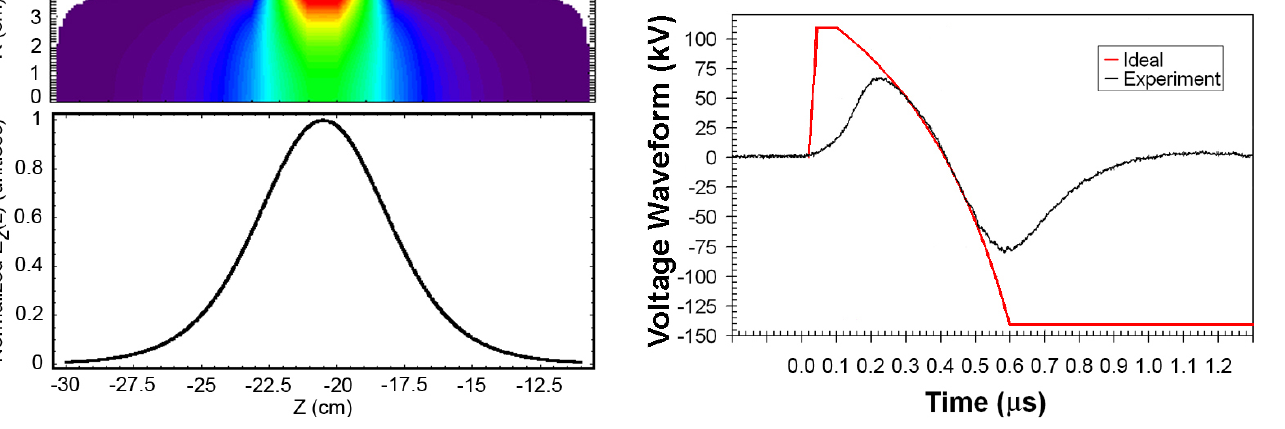
FIG. 2. (Color) In models describing NDCX, the axial coordi- nate is measured in the laboratory frame from Z (cid:8) (cid:1) 30 cm to Z (cid:8) (cid:2) 120 cm . Top: Snapshot (in time) of the E tilt acceleration gap, calculated from the geometry of the currently existing induction module on NDCX. Bottom: Slice of E tilt 0 ; z (cid:5) used in the fluid model to describe the longitudinal spatial dependence of the axial electric field.